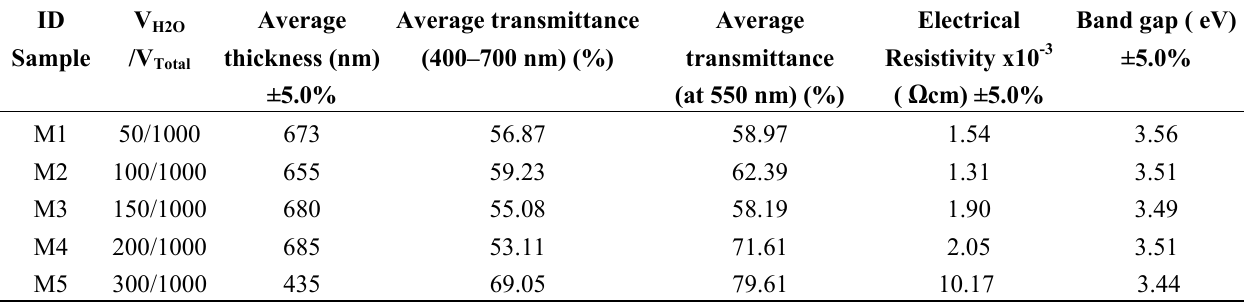
= H O volume; H2O 2